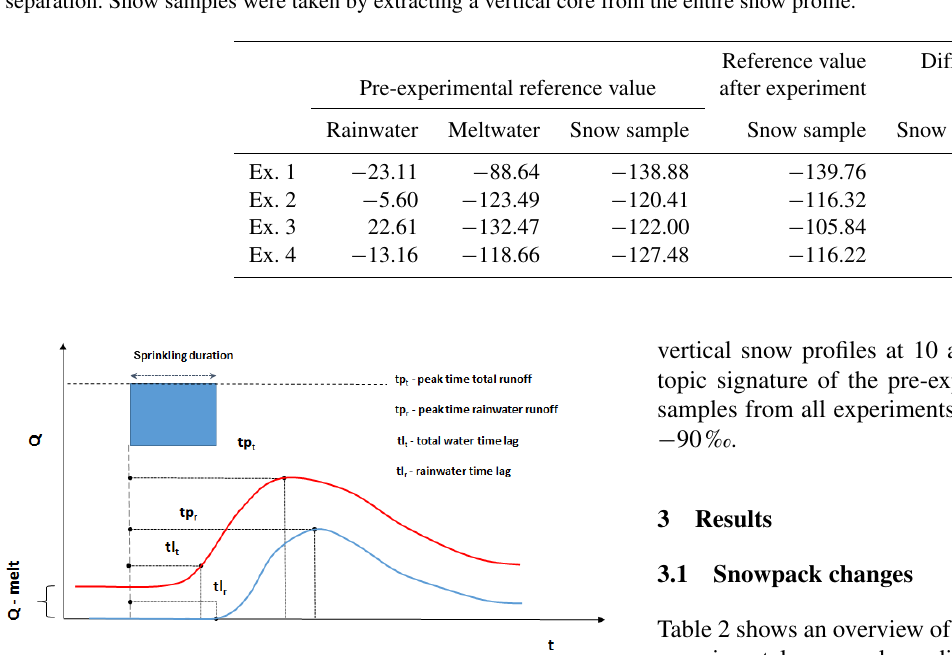
Table 3. Overview of deuterium signature changes within each experiment. Reference values were used in Eqs. (1) and (4) for hydrograph separation. Snow samples were taken by extracting a vertical core from the entire snow profile.